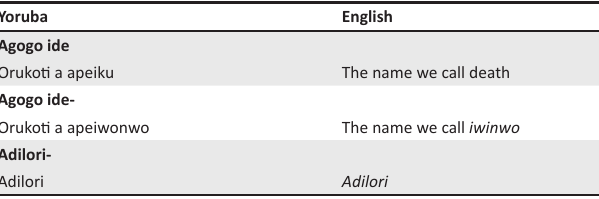
TABLE 1: Yoruba tradition’s potent words that can prevent diseases, deaths and poverty.